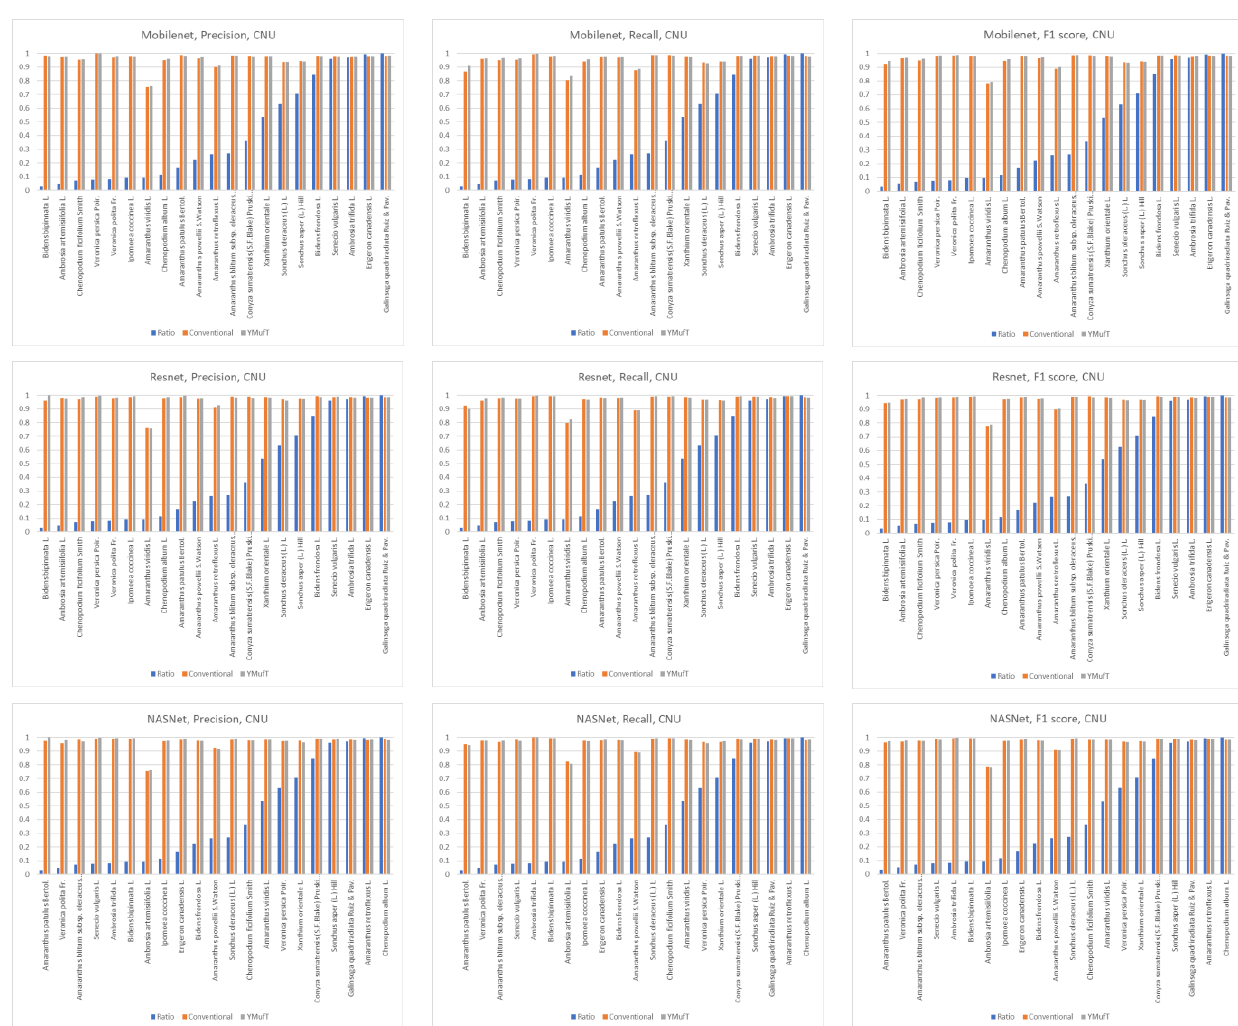
Figure 12. Overall performances on the CNU Weeds test set.